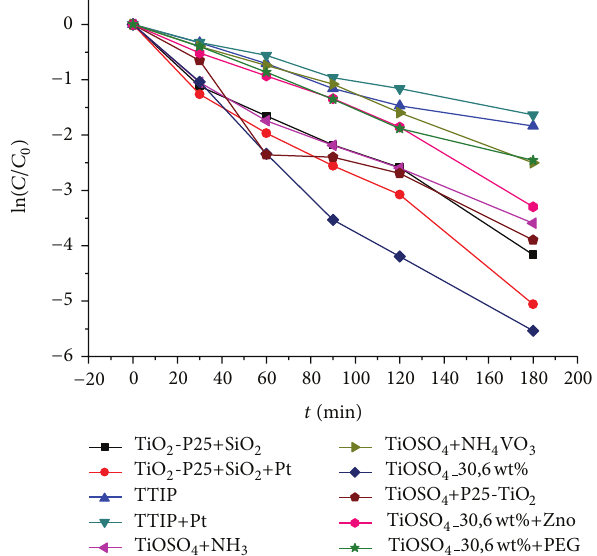
Figure 10: Plot of ln (𝐶/𝐶 0 ) versus t for rate constant determination.